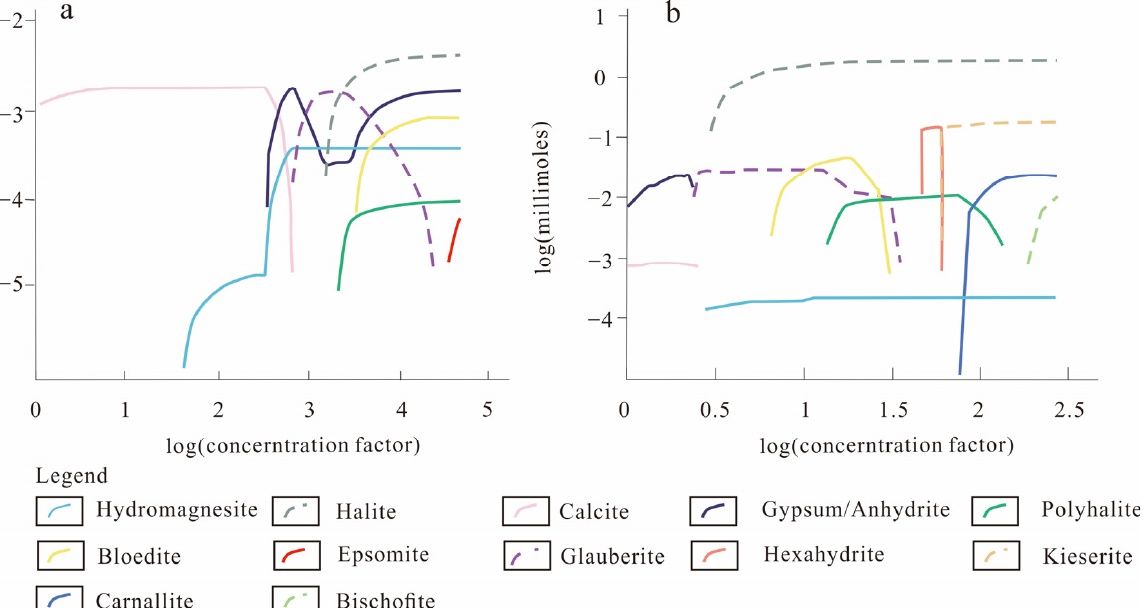
9 of 16 Figure 7. The phase diagram of Na + , K + , Mg 2+ //Cl − , SO 42 − -H 2 O fi ve-element water-element system in the Lop Nor Basin at 25 °C; bis, bischo fi te; car, carnallite; eps, epsomite; blo, bloedite; pic, pic- romerite; syl, sylvite; gla, glauberite; glau, glauber salt.